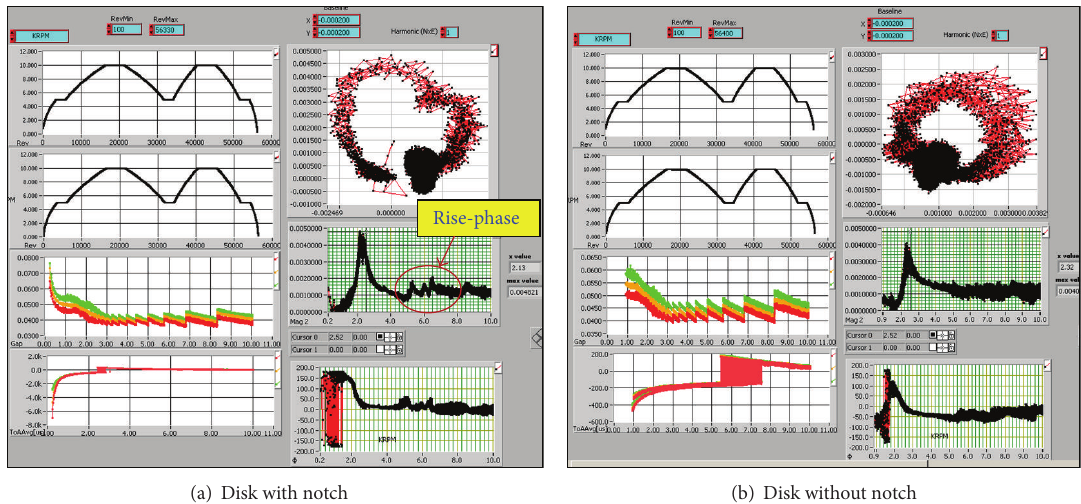
Figure 5: Bode Plots 9 minutes comparison test of the disk with and without notch, capacitive sensor data, Engine cyclic power profile at 5–10Krpm rotational